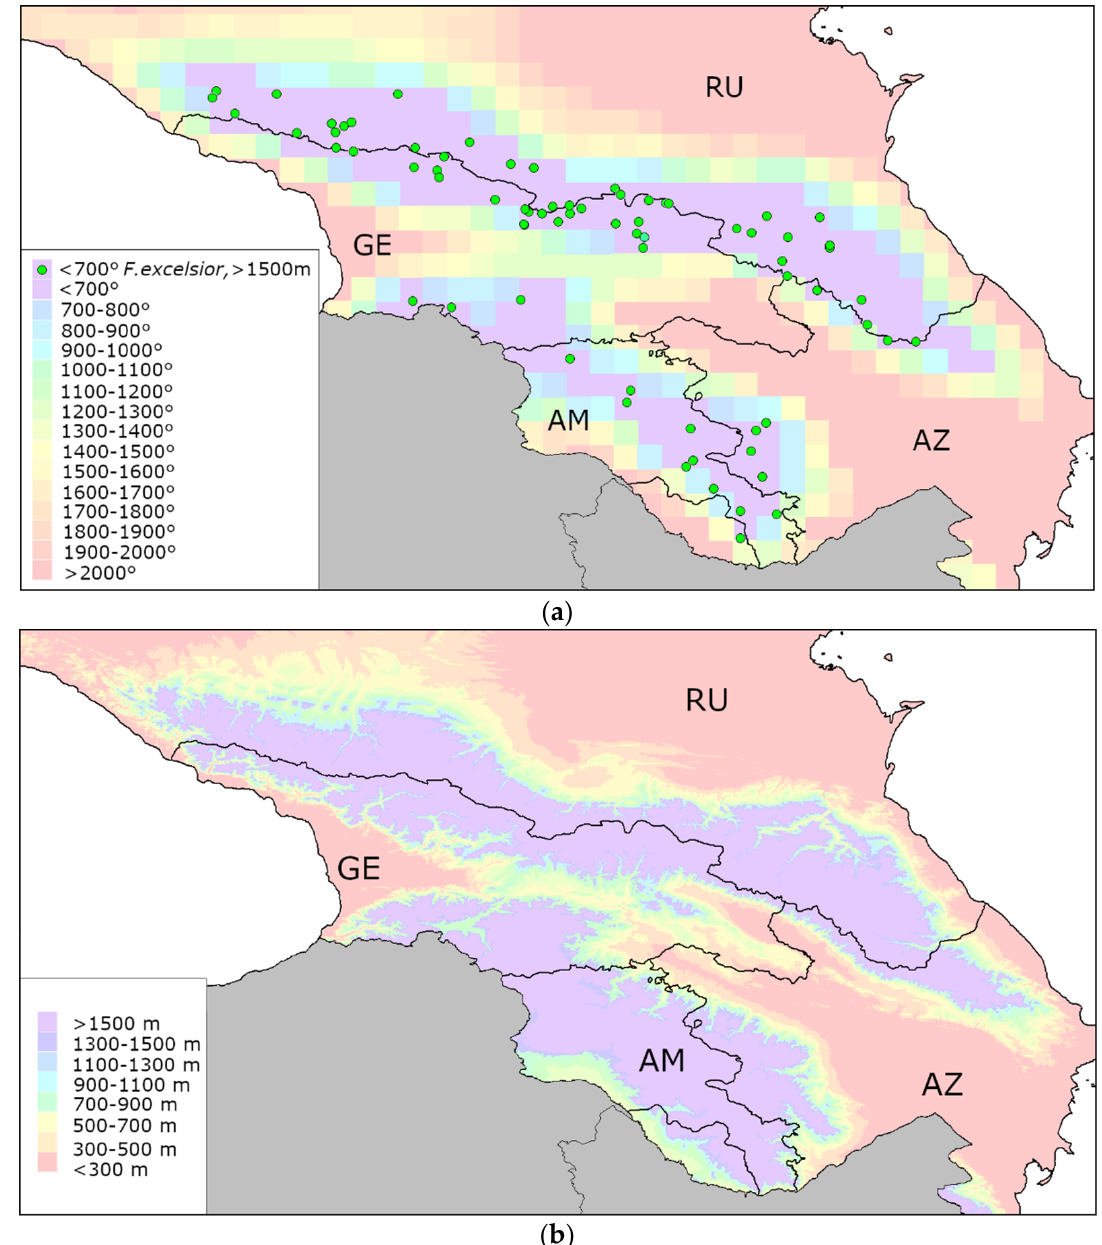
Figure 5. Heat availability and relief of the Caucasus. ( a ) Heat availability: mean AGDD 10 per year in 2003–2020 is indicated with colors; localities of Fraxinus excelsior situated in the grid cells with an AGDD 10 below 700° are indicated with green dots. ( b ) Relief: elevation above sea level indicated with colors. AM—Armenia; AZ—Azerbaijan; GE—Georgia; RU—Russia.